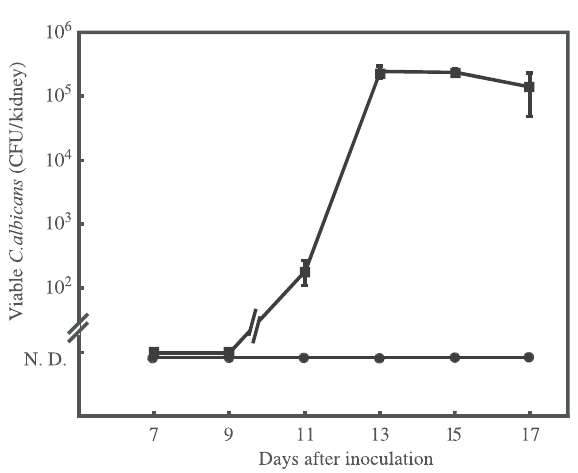
FIG. 2. Viable Candida cells in the kidney of C. albicans- infected mice treated with or without prednisolone. BALB/c mice were infected with 10 6 CFU of C. albicans in their intestinal tracts, then were subcutaneously given 100 mg/kg of prednisolone (squares) and Saline (circles) at 7 and 9 days after this infection. Candida cell counts in kidney were determined at time points thereafter. The results are ex- pressed as a viable count obtained from groups of nine mice per data